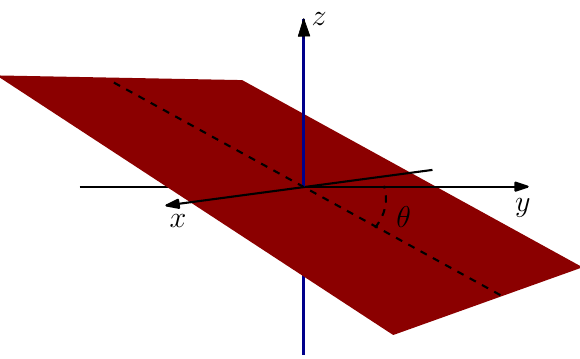
Figure 3 . Support of our example potential. The blue line | coinciding with the z -axis | corresponds to V ? = (cid:14) ( x ) (cid:14) ( y ), while the red plane corresponds to V (cid:3) = (cid:14) (cos (cid:18) z (cid:0) sin (cid:18) y ).